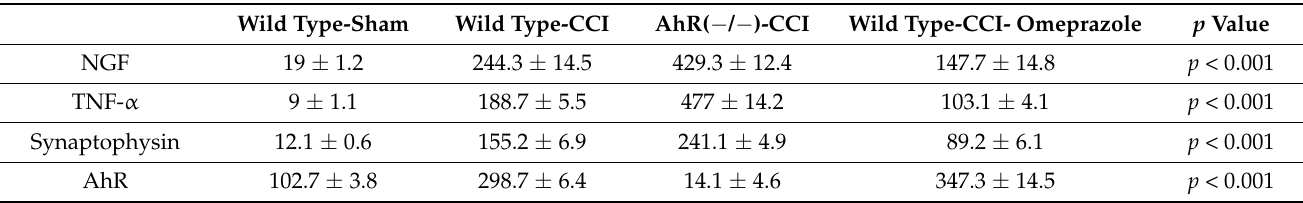
The data are presented as pixels and the method is depicted in the text.